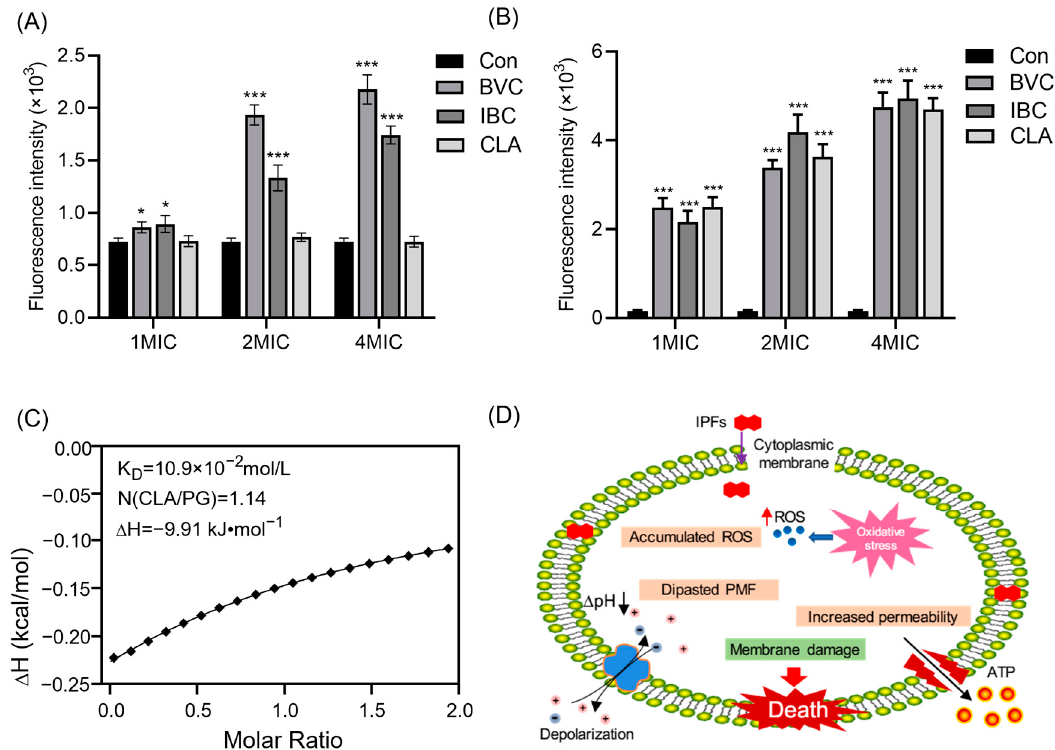
Figure 6. IPFs in PCSs exert antibacterial effects through membranes. ( A ) The effect of IPFs on the ROS accumulation in MRSA. ( B ) The extracellular ATP level of MRSA treated with IPFs. ( C ) Isothermal titration calorimetry (ITC) analysis of the interaction between PG and CLA. ( D ) Mechanism of action of IPFs in Gram-positive bacteria. Values are presented as the mean ± SD. p < 0.05 was considered statistically significant, * p < 0.05, *** p < 0.01 vs. the control (Con) group. The biophysical integrity and function of the CM are critical for bacterial